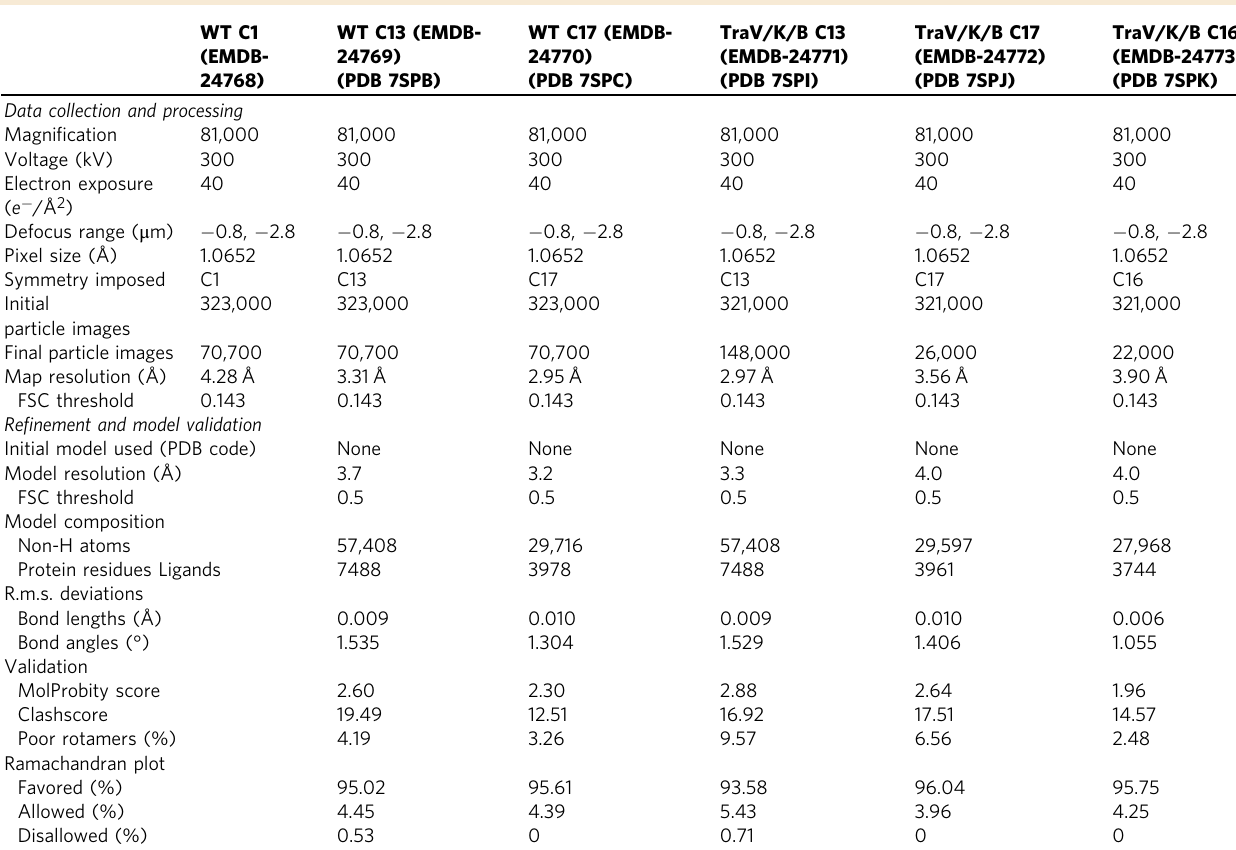
Table 1 Cryo-EM data collection, re fi nement and validation